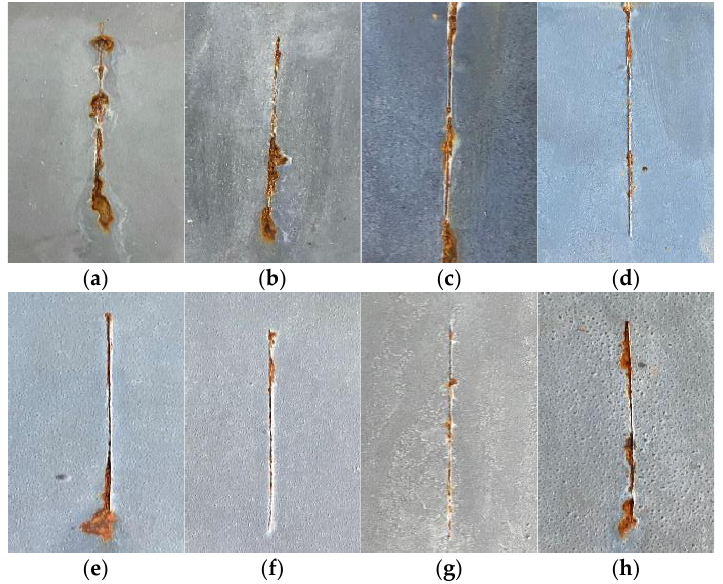
Figure 6. Photo of salt spray resistance in 3.5 wt% NaCl for 1400 h of W-B EZRC ( a ), PANI/W-B EZRC ( b ), GO/PANI-1/W-B EZRC ( c ), CGO/PANI-1/W-B EZRC ( d ), CGO/PANI-2/W-B EZRC ( e ), CGO/PANI-3/W-B EZRC ( f ), CGO/PANI-4/W-B EZRC ( g ), CGO/PANI-5/W-B EZRC ( h ).